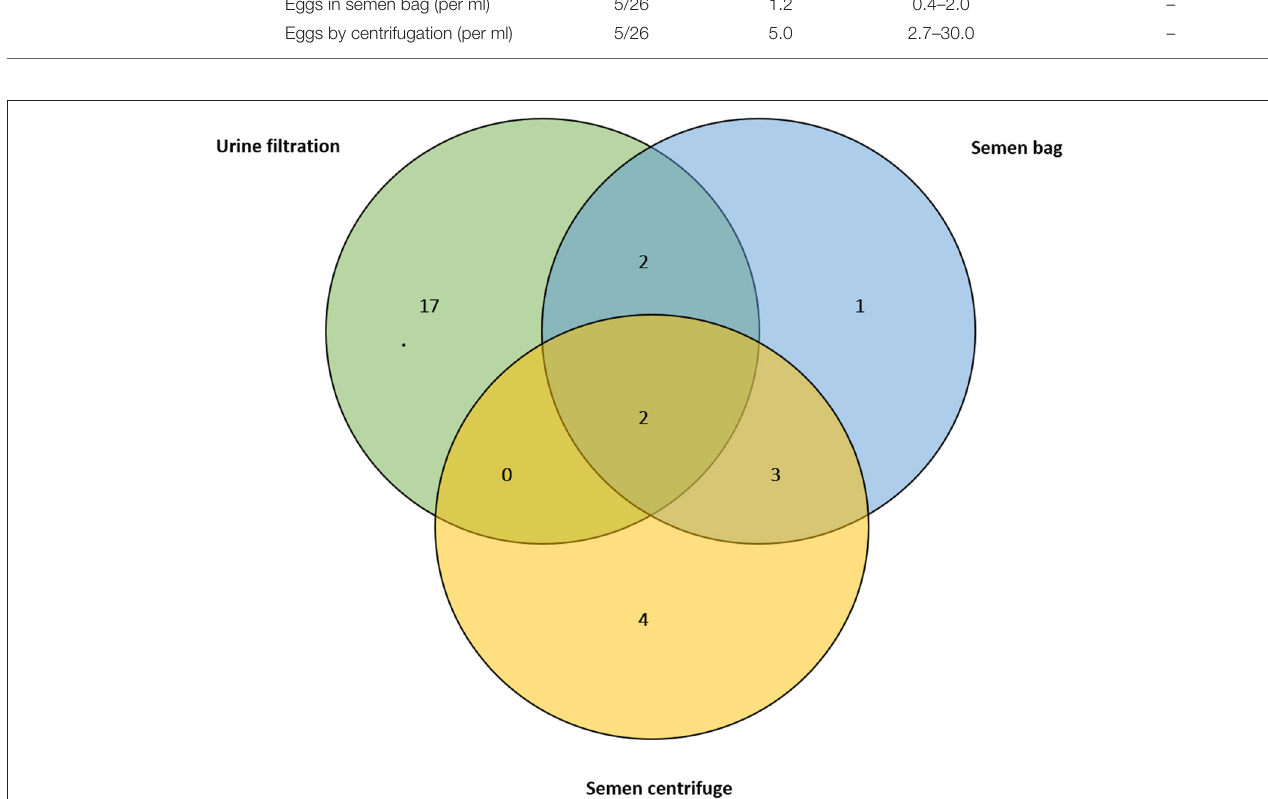
FIGURE 4 | Venn diagram showing positive results of the urine filtration, semen microscopy using bag and centrifugation methods on those participants who submitted semen at baseline ( n = 114).